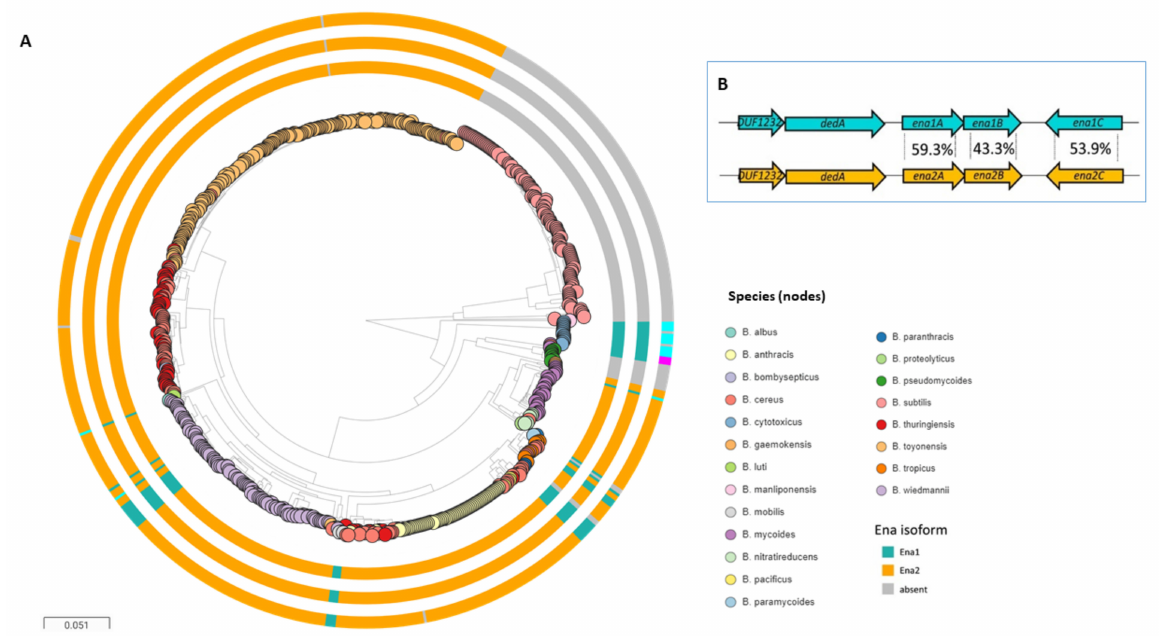
Figure 3. The ena1 and ena2 gene loci and distribution of these among 735 Bacillus genomes. ( A ) Distribution of ena1/2A-C among B. cereus s.l. spp. and the presence of genes encoding Ena subunits are indicated on surrounding rings in the following order from inner to outer: presence of enaA , enaB , and enaC , respectively (for all three, ena1 : teal, ena2 : orange, different locus: cyan). When no homolog or ortholog was found, the ring is gray. Whole genome clustering of the B. cereus s.l. group and B. subtilis created by Mashtree [52,53] and visualized in Microreact [54]. Rooted on B. subtilis . ( B ) (Inset) Ena1 and Ena2 loci with average amino acid sequence identity indicated between the population of EnaA-C orthologs and homologs found within the B. cereus s.l. group. Reprinted from